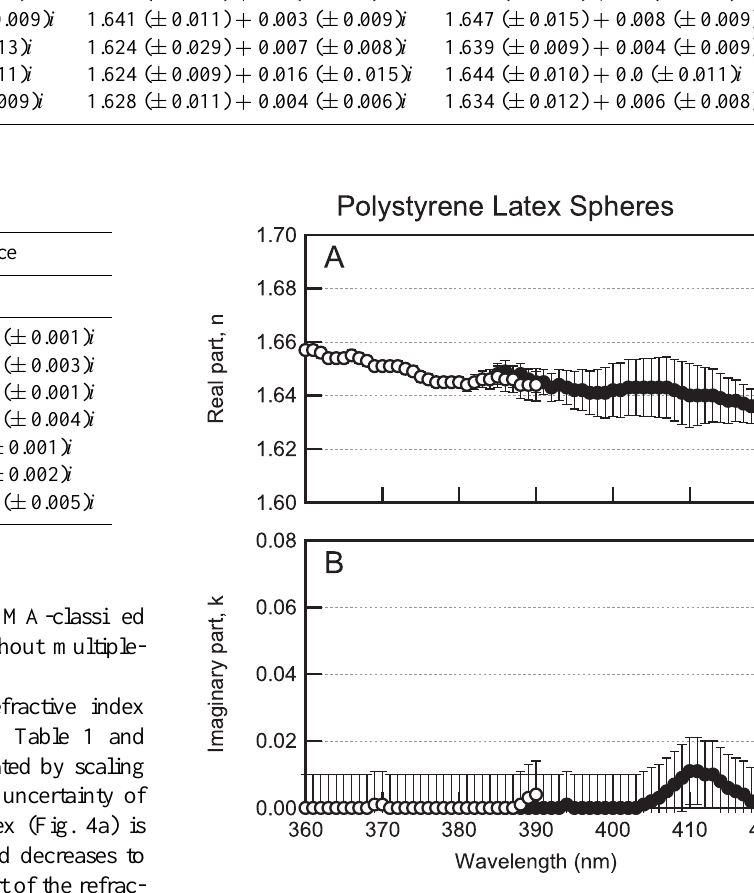
Fig. 4. (a) The real part of the complex refractive index (RI) as a function of wavelength for the BBCES 360–390nm (open circles) and the BBCES 385–420nm (filled circles). (b) The imaginary part of the